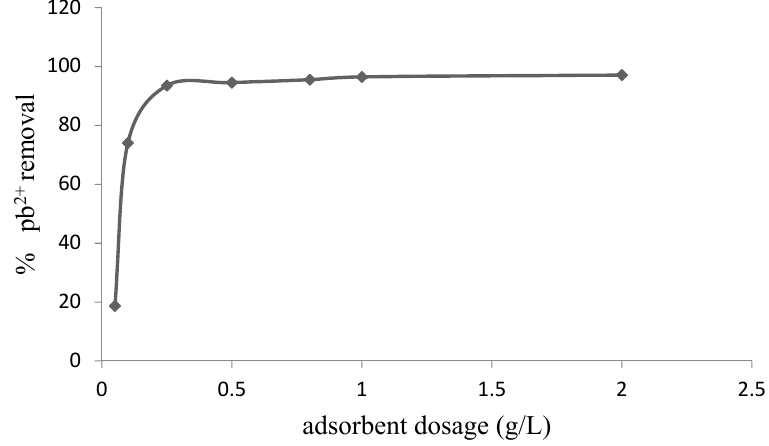
Figure 4. Variation of percent Pb 2+ removal with adsorbent dosage (initial concentration = 10.7 mg/L, contact time = 40 min, T = 298 K, pH = 4, shaking speed = 250 rpm).